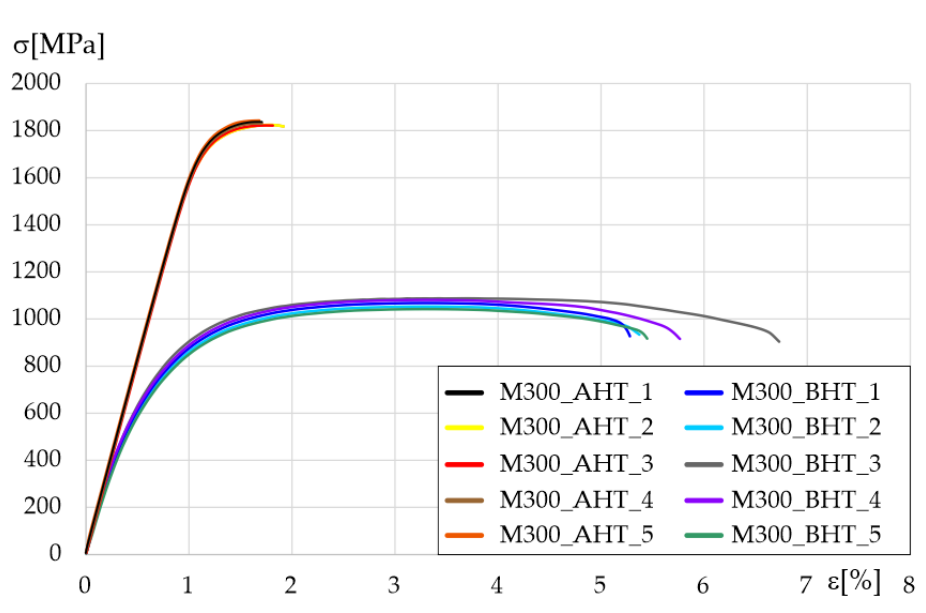
Figure 9. Tensile test results of M300 steel in AHT and BHT conditions.